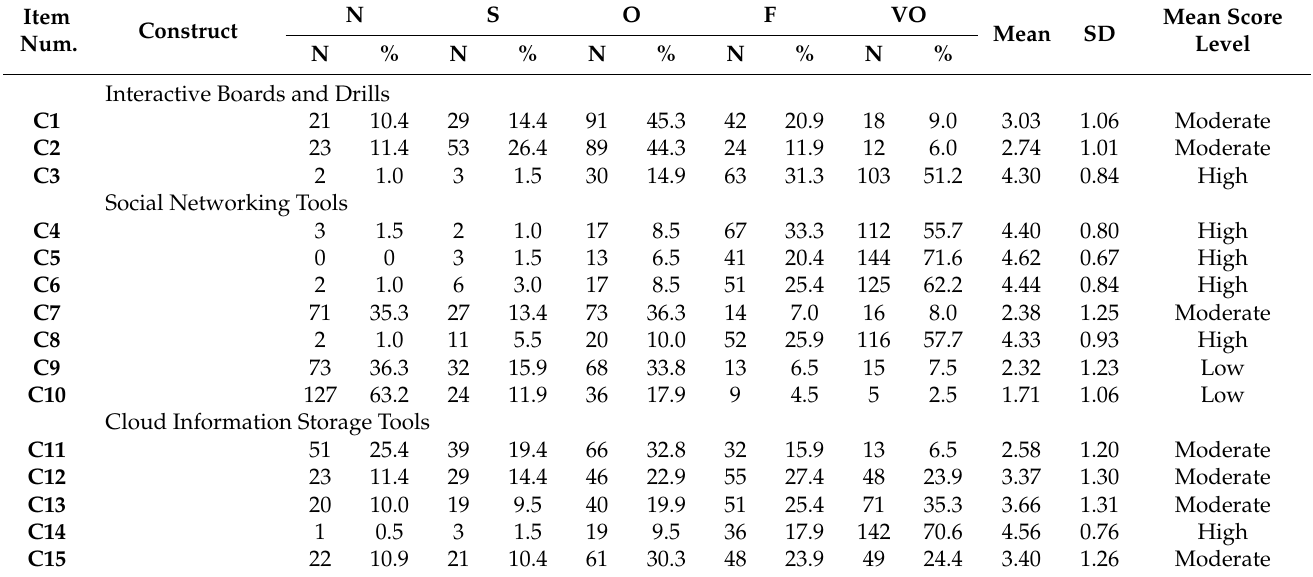
Table 7. Levels of Use of Learning Media Among Form